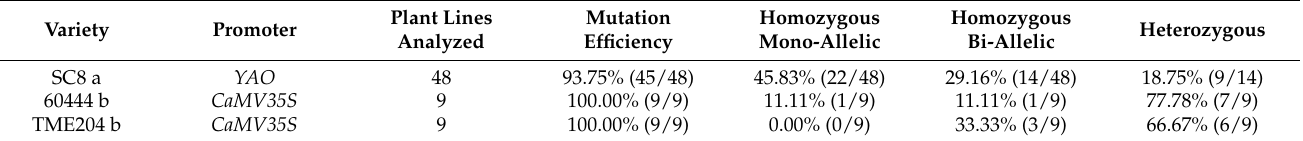
Table 6. Comparison of the mutation types at the same target site by YAO or CaMV35S promoter- driven CRISPR/Cas9 vector.